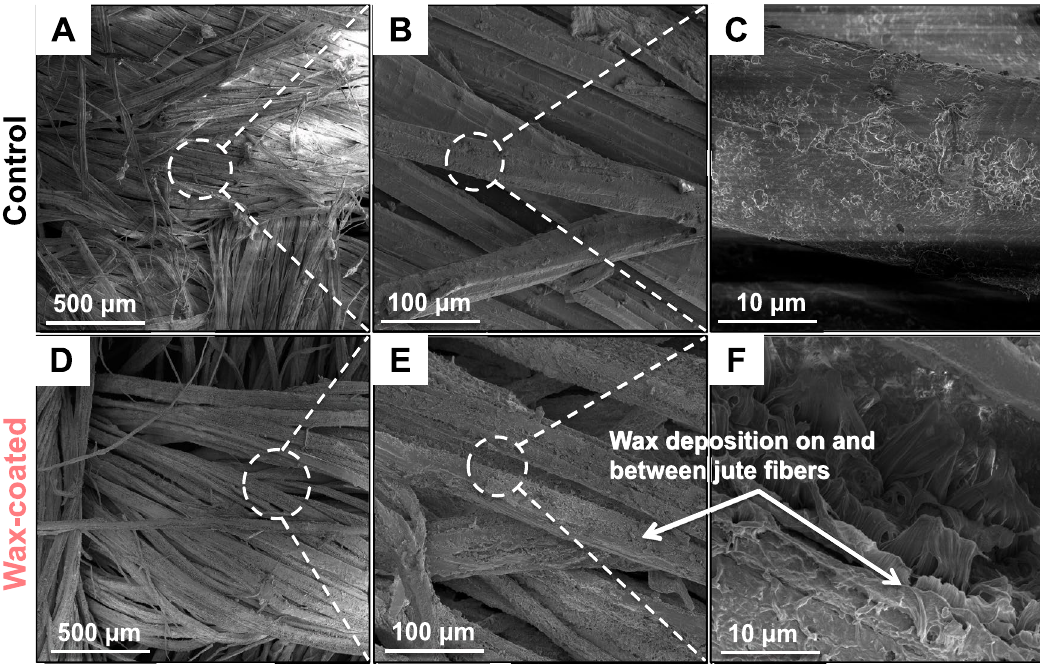
Figure 2. Representative scanning electron micrographs of jute fiber surface morphologies of control jute bags (CJBs) and wax-coated jute bags (WCJBs). Fibers of CJBs ( A – C ) show lower surface roughness in comparison to WCJB fibers ( D – F ). Wax deposits are also indicated with